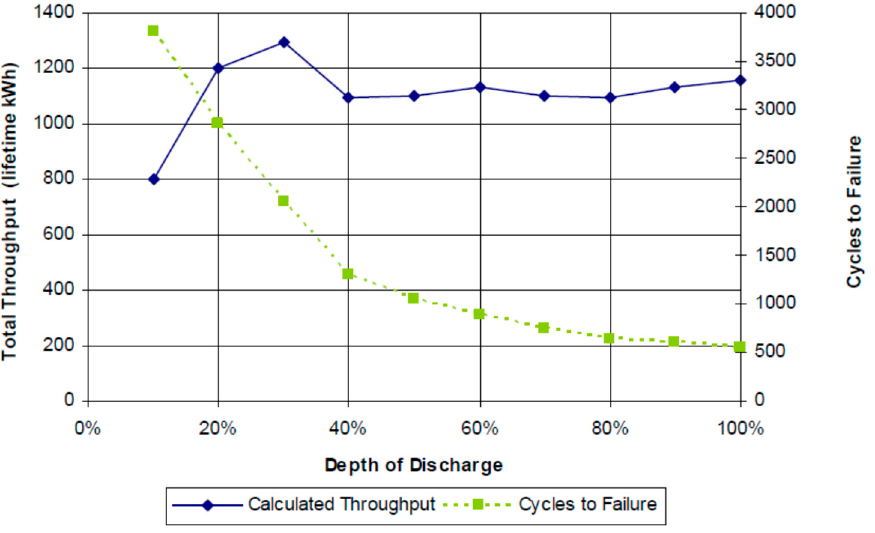
Figure 2. Lead–acid battery behavior [22].